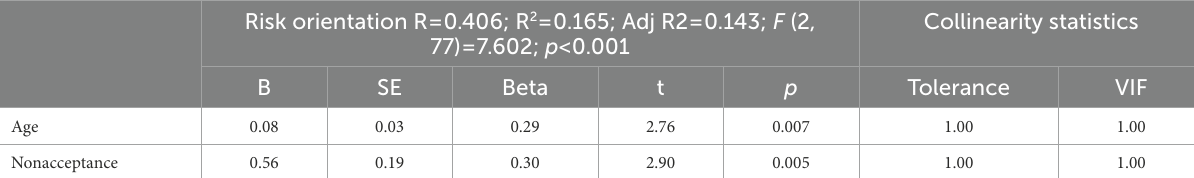
TABLE 4B Multiple regression model performed on risk orientation with age and nonacceptance (emotional dysregulation’s subscale) as independent